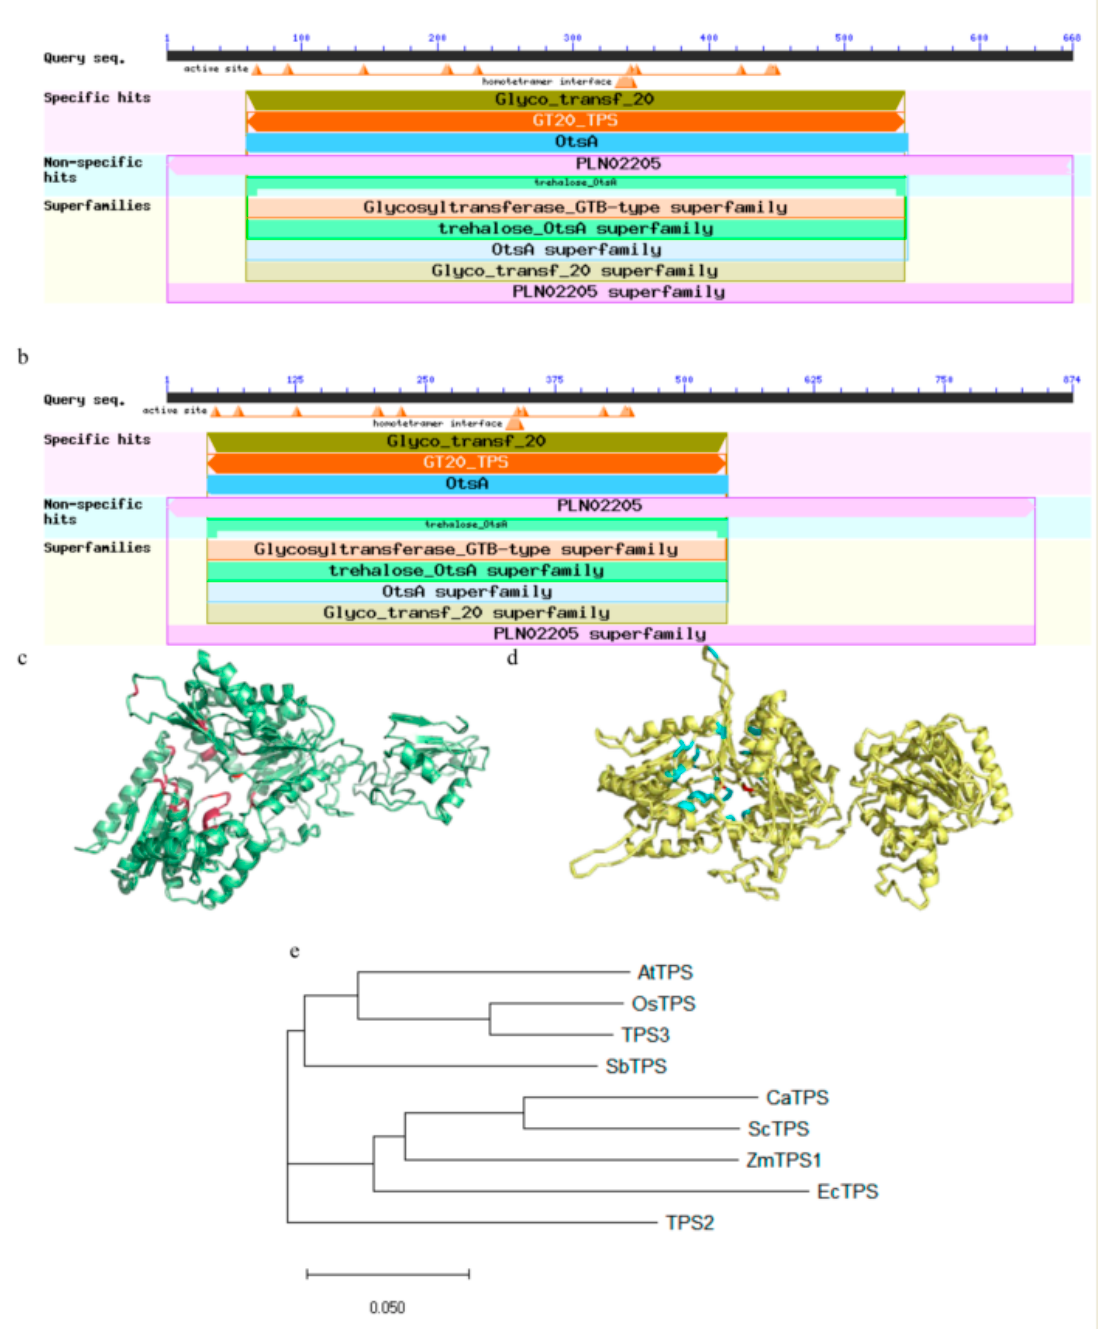
Figure 1. Amino acid sequence analysis and phylogenetic relationship of TPS-2 and TPS-3. ( a ) Domain analysis of the TPS-2 gene; ( b ) Domain analysis of the TPS-3 gene; ( c ) Computational modeling of TPS-2 ; ( d ) Computational modeling of TPS-3 ; ( e ) Phylogenetic tree of the amino acid sequences of TPS-2 and TPS-3 .